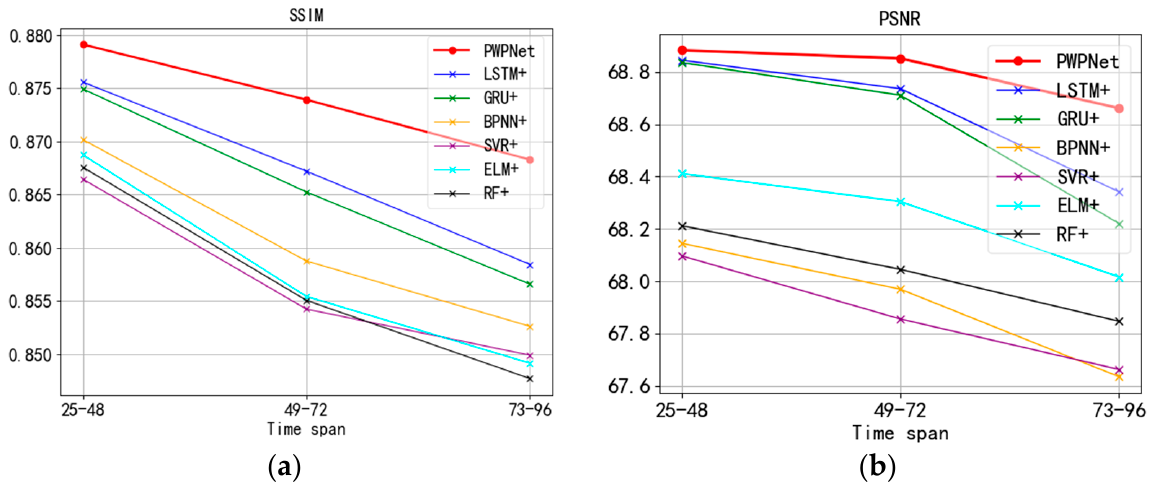
Figure 12. Comparison of PWPNet with other cascaded models, metrics are SSIM ( a ) and PSNR ( b ).